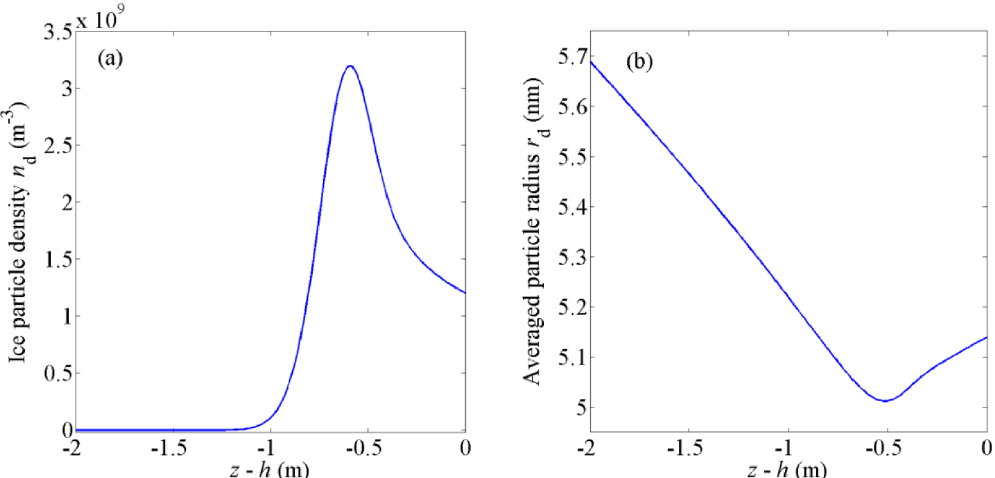
Figure 5. The distribution of (a) ice particle density and (b) the averaged particle radius near the upper boundary of the condensation layer.